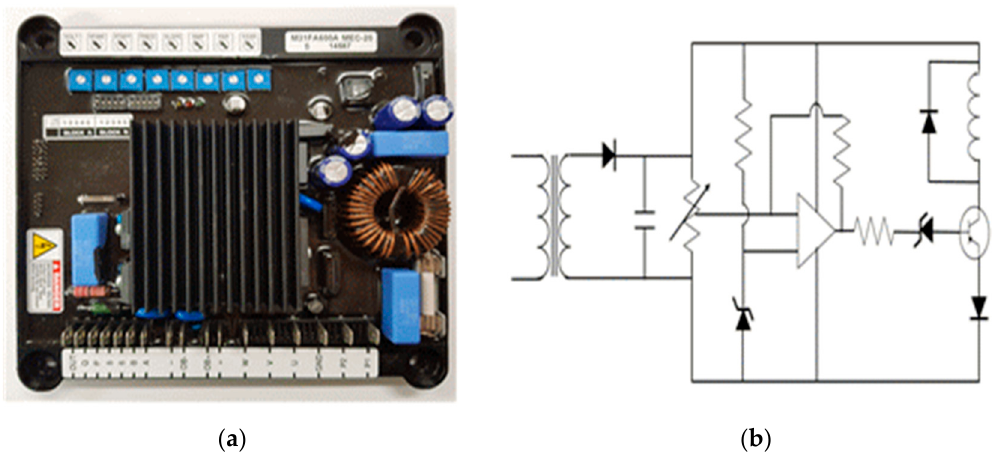
Figure 13. ( a ) Internal structure of automatic voltage regulator, and ( b ) the reference voltage control circuit .